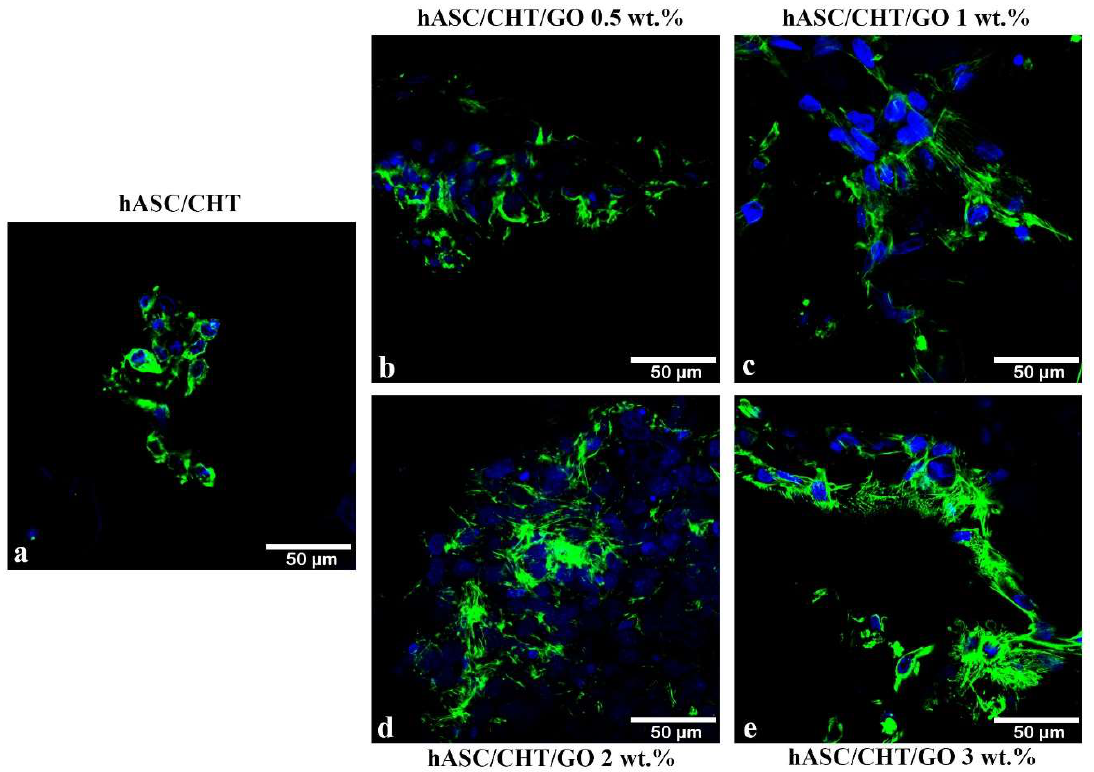
Figure 2. Actin filaments developed by hASCs after 48 h of contact with CHT/GO ( b–e ) and the CHT reference ( a ), as shown by confocal microscopy. Scale bar 50 μm. Actin filaments are shown in green (phalloidin-fluorescein isothiocyanate (FITC)) and cell nuclei are shown in blue (DAPI).